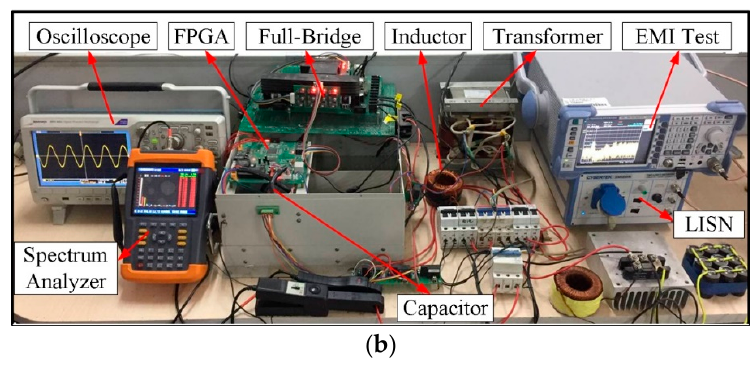
Figure 12. Experimental platform of a single-phase full-bridge APF: ( a ) Nonlinear loads; ( b ) Experimental platform. Table 2. Main Experimental Devices.